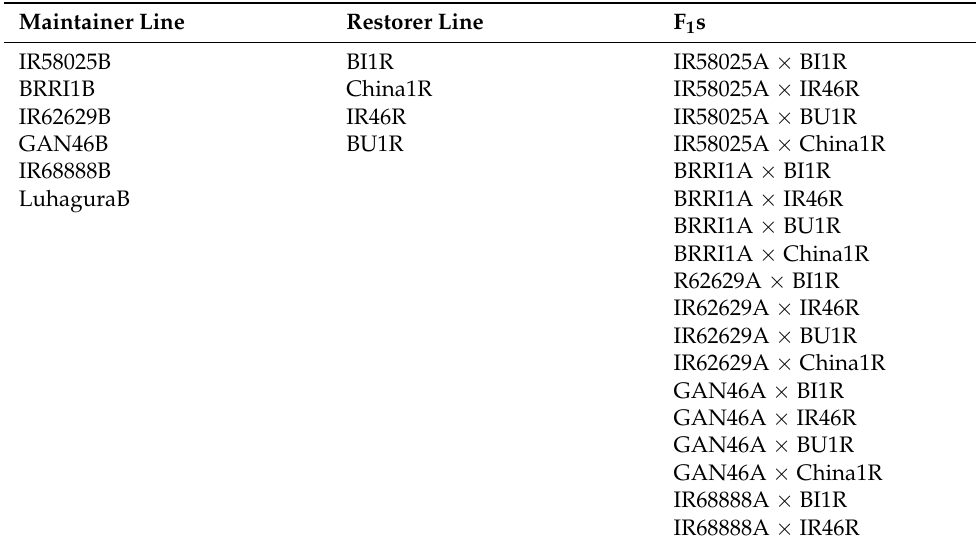
Table 1. Name of maintainer and restorer lines with their F 1